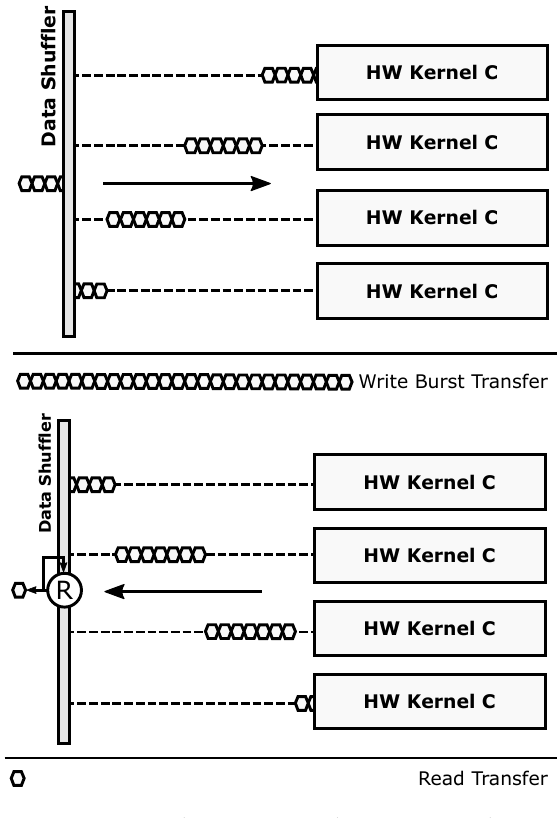
Figure 6. Reduction-oriented operation mode.